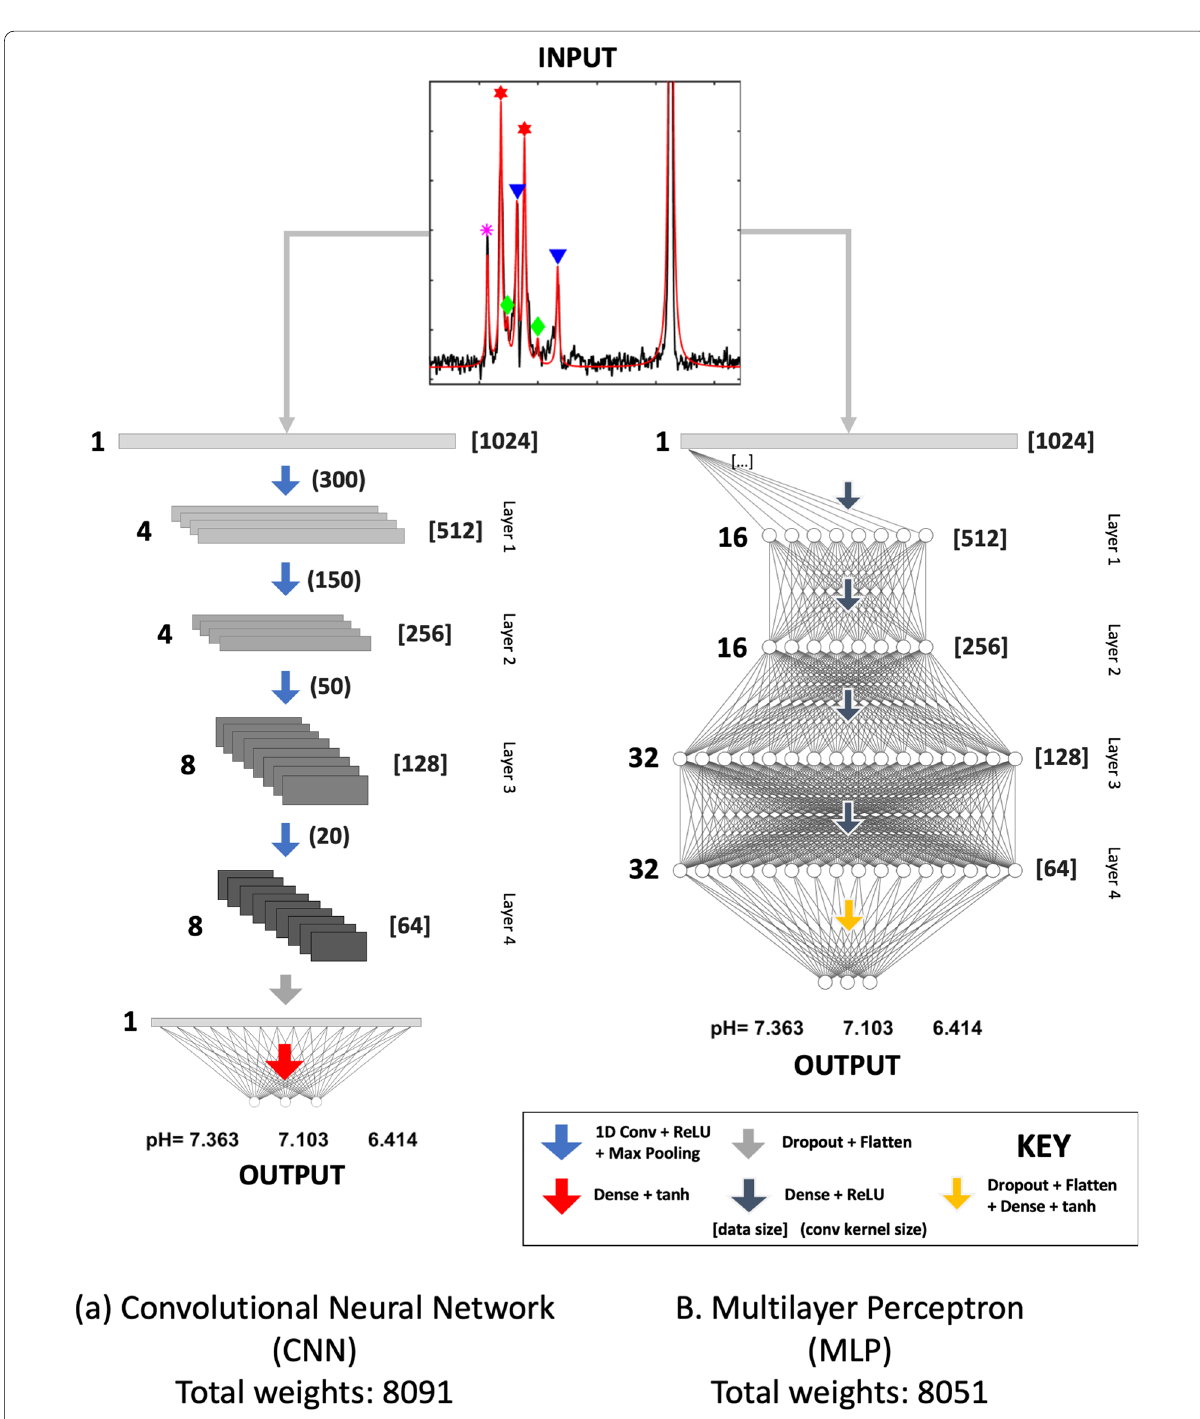
Fig. 1 Schematic diagram of the neural network architecture for the a convolutional neural network (CNN) and the b multilayer perceptron (MLP). Both the proposed CNN and MLP consist of 4 feature extraction layers, for which they learnt a mapping between the input spectra and multiple pH e compartments. To compare the performance of CNN and MLP in correctly predicting pH e compartments, the architectures were set to a similar number of weights, 8000. The length of the spectrum or feature maps, which are used as the input to each next convolutional or dense ≈ layer, are shown in the square brackets. In CNN, the lengths are scaled logarithmically. CNN: The number of filters is 4, 4, 8, and 8. The sizes of the convolutional kernel are shown in the round brackets. MLP: The number of neurons is 16, 16, 32, and 32. Dense layers are represented with half (MLP) or quarter (CNN) the number of nodes, except for output